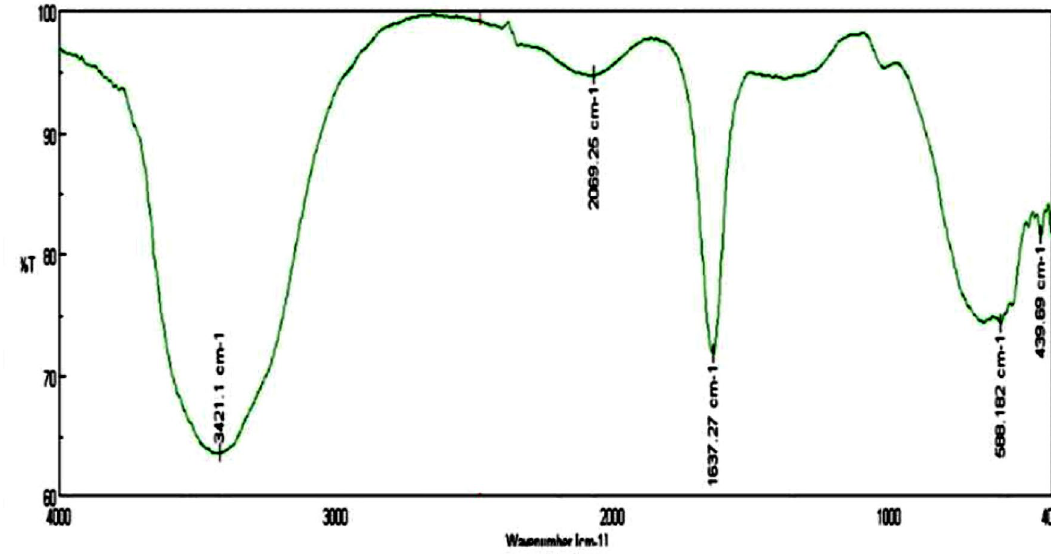
Figure 2. FTIR spectrum of Lawsonia inermis -mediated bio-synthesized ZnO NPs.